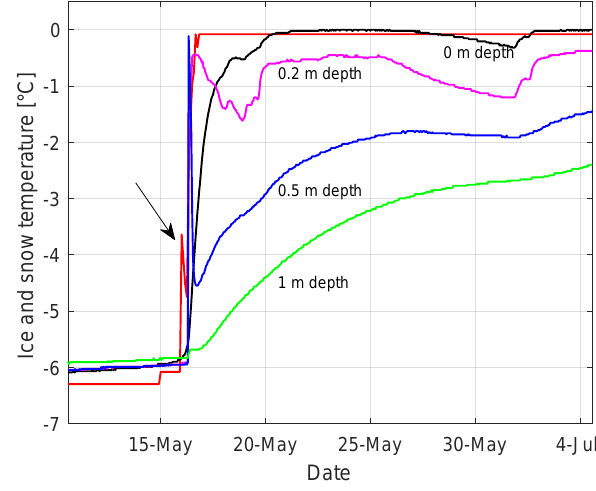
Figure 14. Plot of temperature measurements in ice and snow at the onset of thaw in May 2010 (position at the thermistor shown in Fig. 3a). The depth reference is the ice surface the previous autumn. The red line is the snow temperature 0.25m from the base of the snow cover. The arrow points to the first signal of surface meltwater refreezing close to the base of the snow cover.